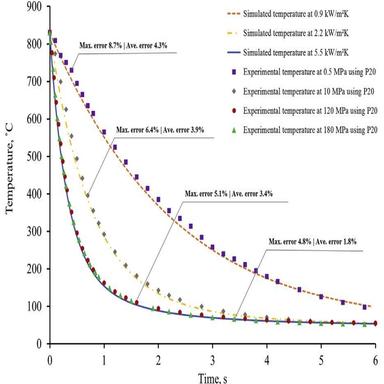
The temperature histories of the Ti-6Al-4V from 0.5 to 180 MPa under dry conditions quenched by the P20 tools.